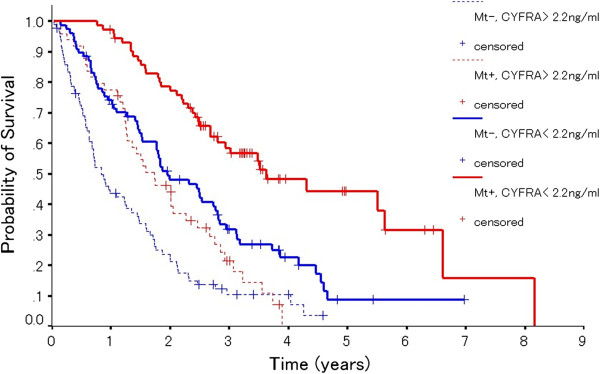
Kaplan-Meier curves for overall survival in four groups, EGFR mutation status- stratified by PCV. M+: mutant EGFR, M-: wild-type EGFR, PCV: pretreatment CYFRA 21–1 value.